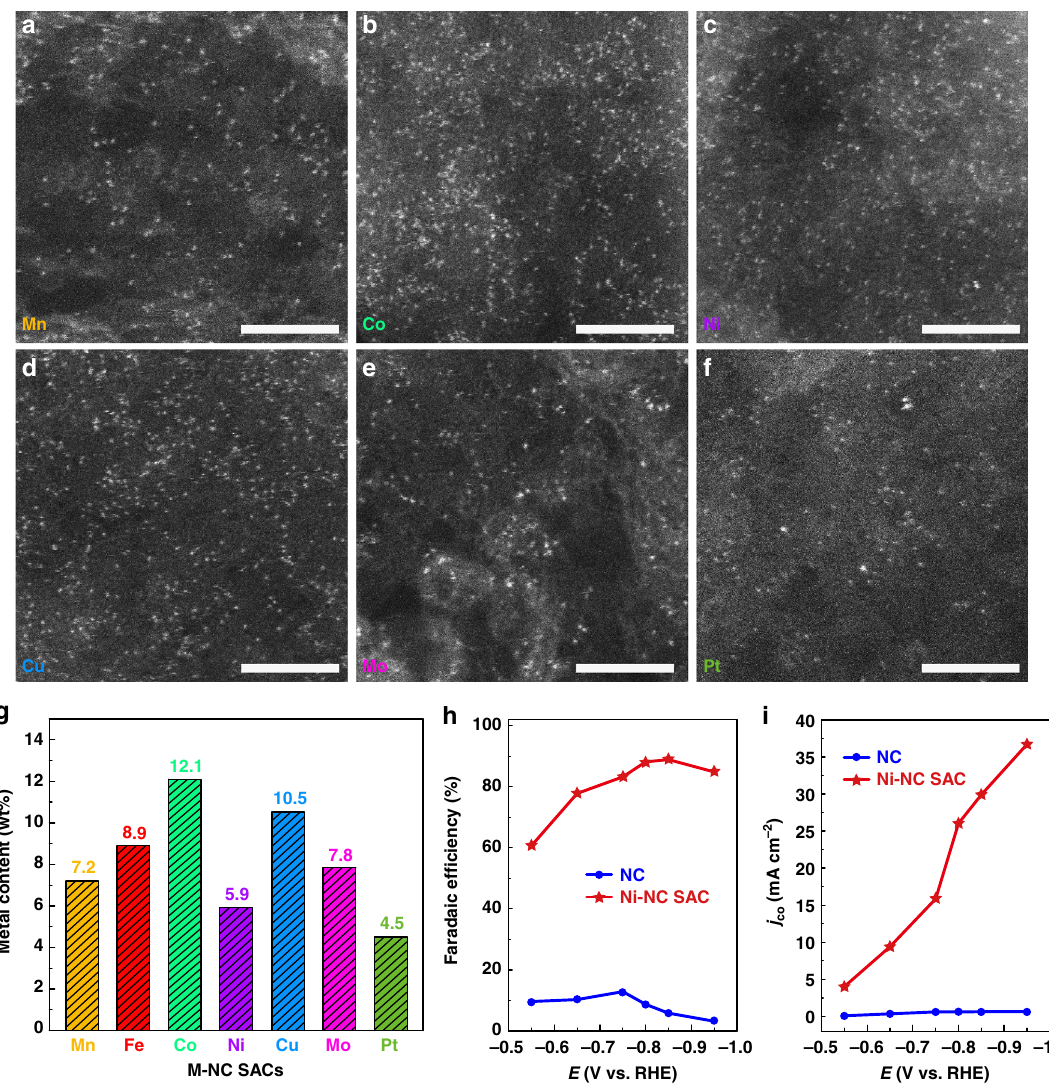
Fig. 6 Atomic structure characterizations and loading analysis of M – NC SACs. a – f HAADF – STEM images for Mn – NC SAC ( a ), Co – NC SAC ( b ), Ni – NC SAC ( c ), Cu – NC SAC ( d ), Mo – NC SAC ( e ), and Pt – NC SAC ( f ). Scale bars, 3 nm ( a – f ). g Metal loading in M – NC SACs. h Faradaic ef fi ciency of CO, and i ,